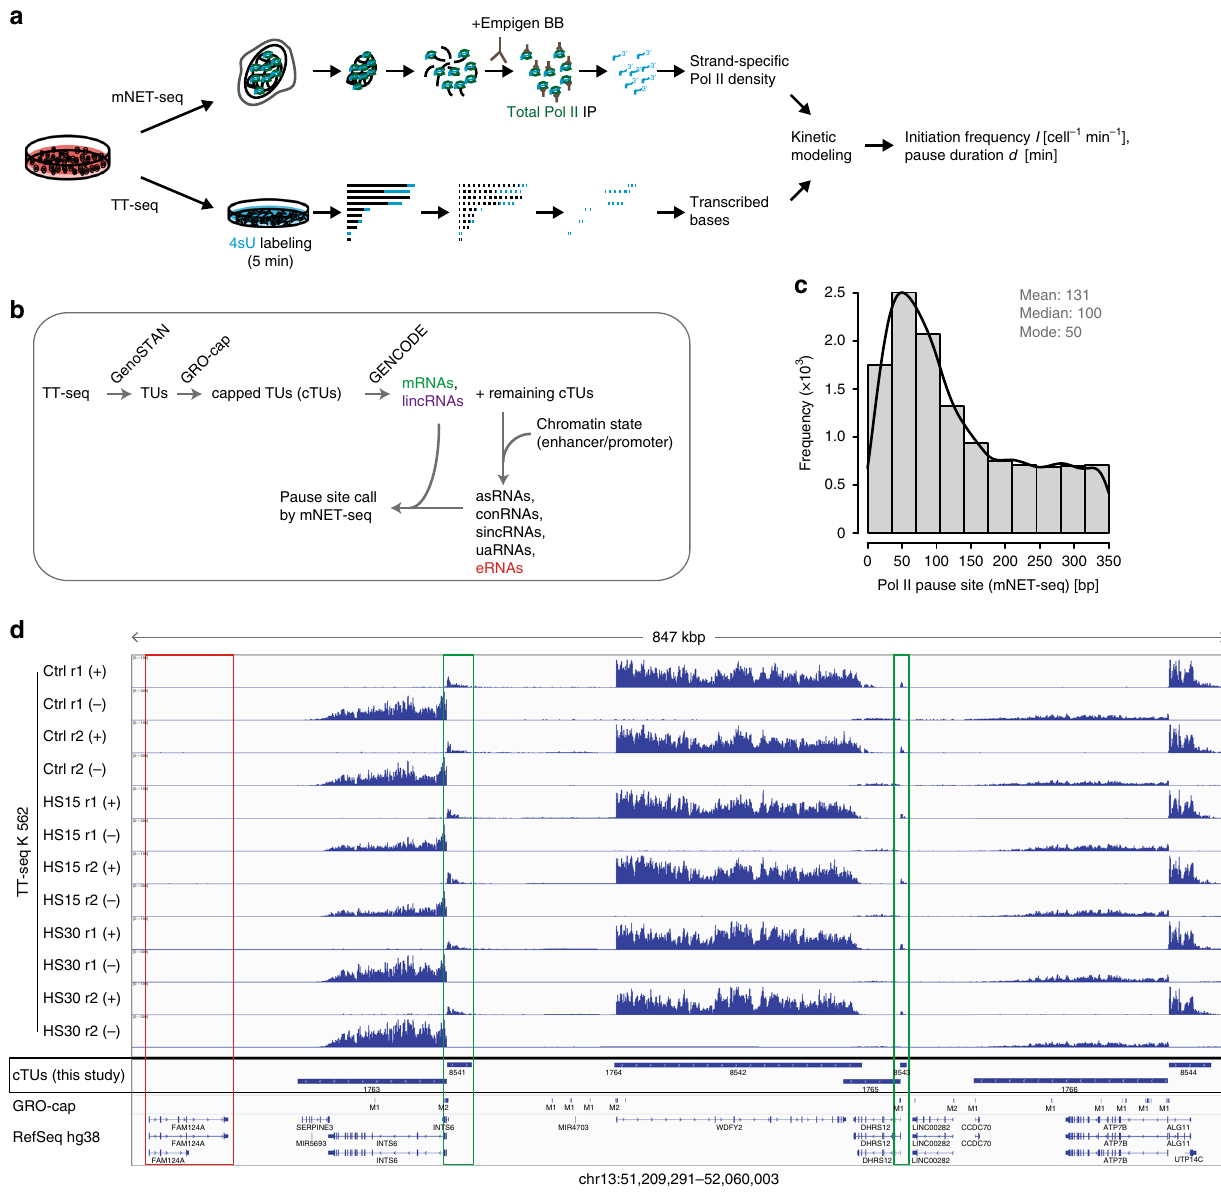
Fig. 1 Multiomics analysis and annotation of different gene classes in human K562 cells. a Experimental schematic of multiomics approach. Human K562 cells were subjected to TT-seq to estimate the productive initiation frequency I [cell − 1 min − 1 ]. By combining TT-seq data with mNET-seq the pause duration d [min] is calculated ( “ Methods ” ) 28 . b Schematic overview of capped transcription unit (cTU) annotation in K562 cells. First, TT-seq data ( n = 6) were subjected to the genomic segmentation algorithm GenoSTAN 42 . The transcription start sites (TSSs) were further re fi ned by published GRO-cap data generated in K562 cells 43 . To call promoter-proximal pause sites mNET-seq data ( n = 6) generated in K562 cells were used. (Supplementary Table 1, Supplementary Fig. 1). c Distribution of pause site distance [bp] for 12,160 investigated cTUs measured by mNET-seq depicted as a histogram with respect to GRO-cap re fi ned TSS (mean 131 [bp], median 100 [bp], and mode 50 [bp]). d Genome browser view of a 847-kbp region located in chromosome 13 (chr13: 51,209,291 – 52,060,003) visualized with the Integrative Genomics Viewer (IGV, version 2.4.10; human hg38) 81 . From top to bottom, tracks represent: TT-seq coverage in K562 cells ( n = 6) on respective plus ( + ) or minus ( − ) strand, GRO-cap data 43 , new cTU annotation, RefSeq GRCh38 annotation. cTUs missing in the RefSeq GRCh38 annotation are highlighted in a green. RefSeq transcript not present in K562 cells is highlighted in